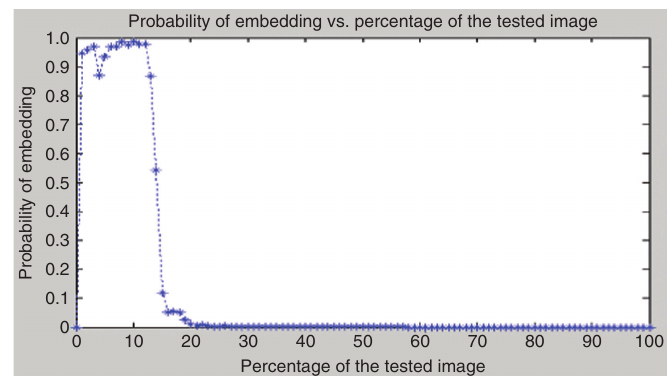
Figure 2. Man Image.